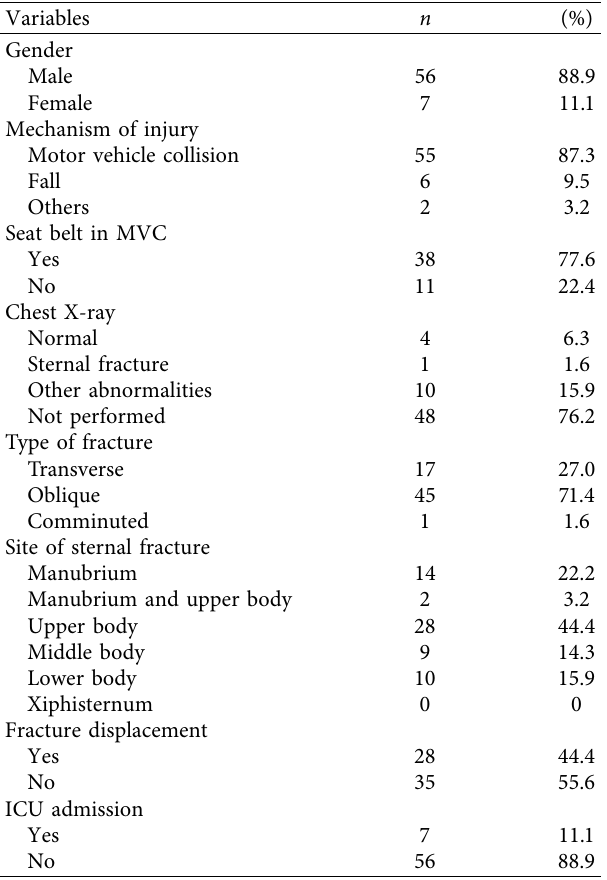
Table 1: Te frequency distribution of patients across diferent